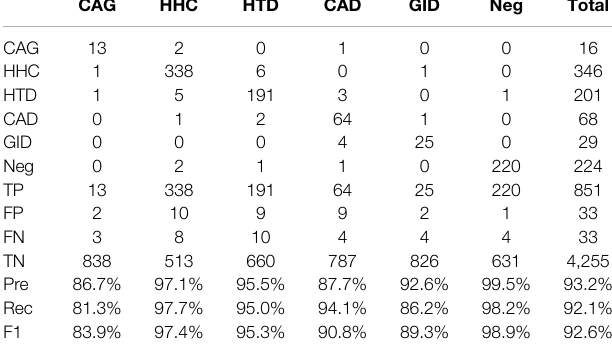
TABLE 4 | Hyperparameter tuning range.